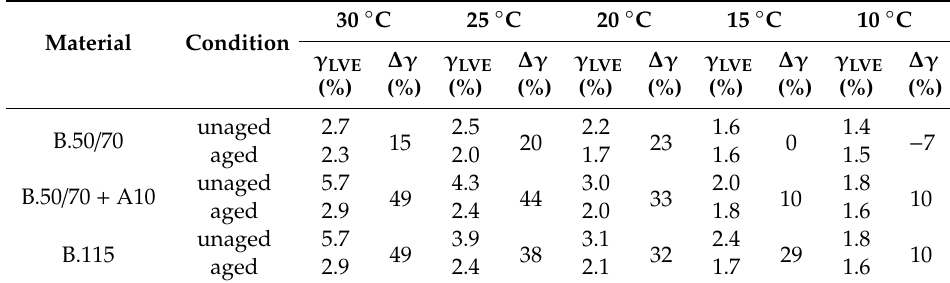
Table 2. Variation of γ LVE for each material at each temperature and percentage variation due to aging.